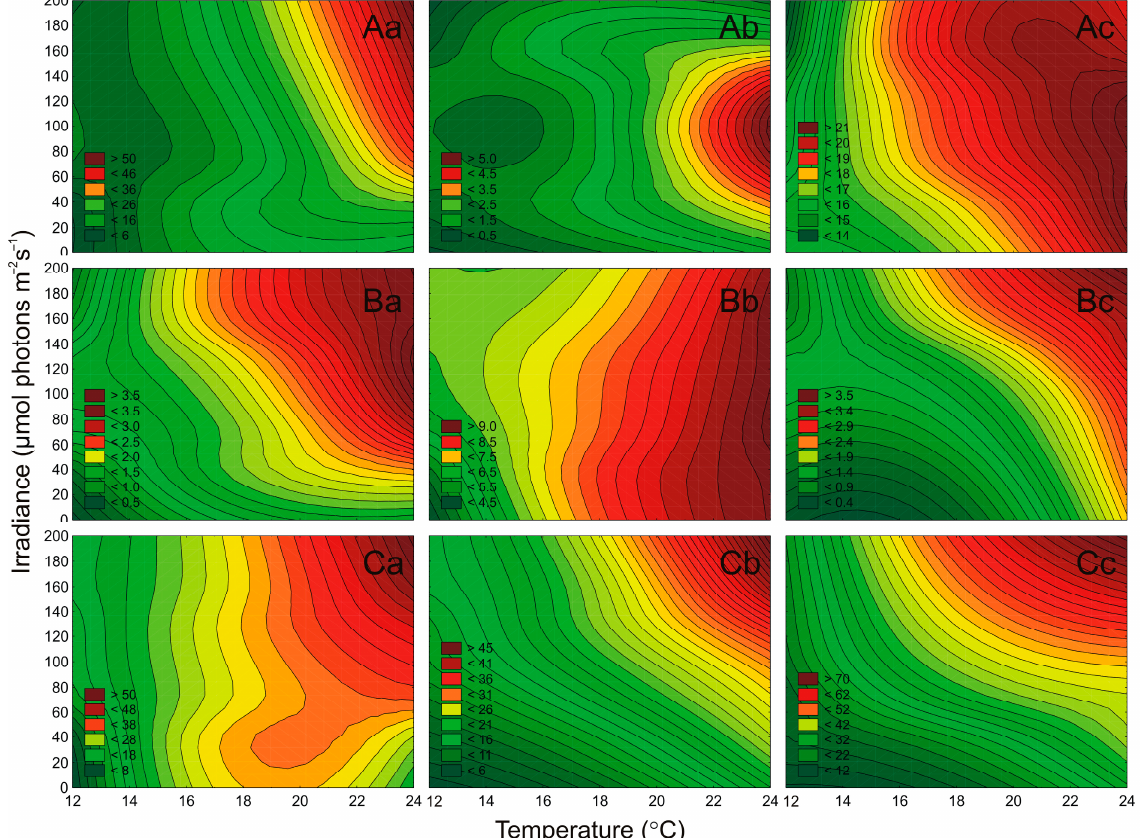
Figure 3. The number of cells (N × 10 5 mL –1 ) obtained after 7 days of experiment for airborne cyanobacteria: Nostoc sp. ( Aa ), Synechococcus sp. ( Ab ), and Aphanothece sp. ( Ac ); airborne green algae: Oocystis sp. ( Ba ), Coccomyxa sp. ( Bb ), and Kirchneriella sp. ( Bc ); airborne diatoms: Nitzschia sp. ( Ca ), Amphora sp. ( Cb ), and Halamphora sp. ( Cc ) under different irradiance (µmol photons m –2 s − 1 ) and temperature (°C) conditions.